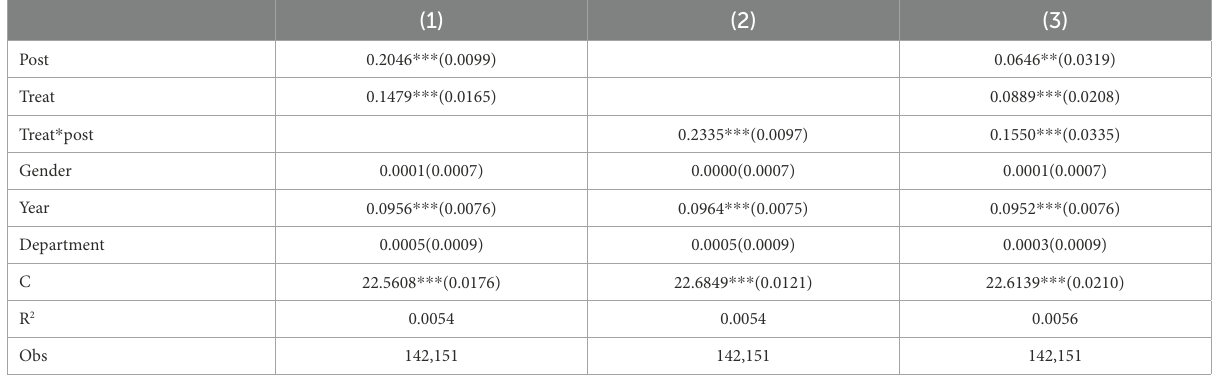
TABLE 5 Online teaching intervention and students’ LPCFL: DID